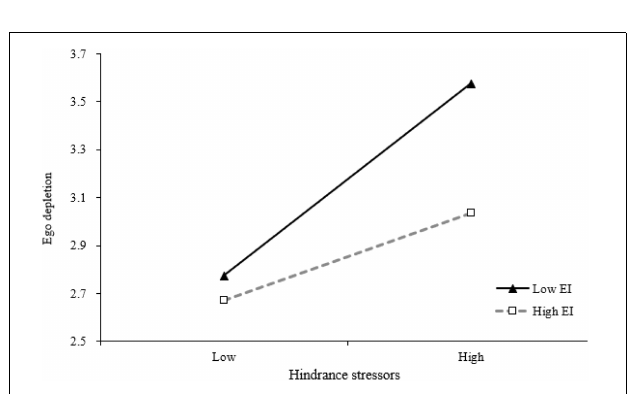
FIGURE 2 | Interactive effects of challenge stressors and emotional intelligence (EI) on ego depletion.